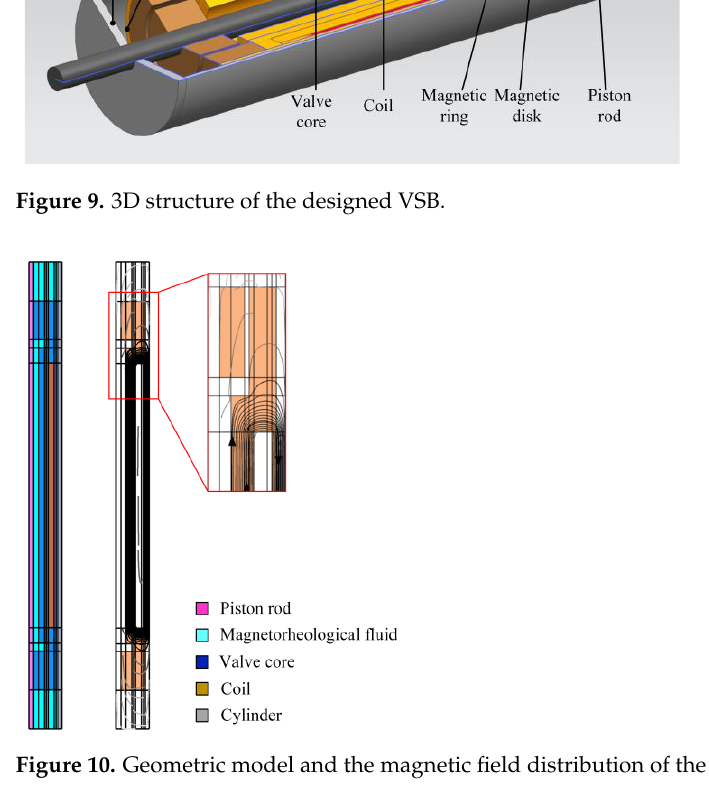
Figure 9. 3D structure of the designed VSB.